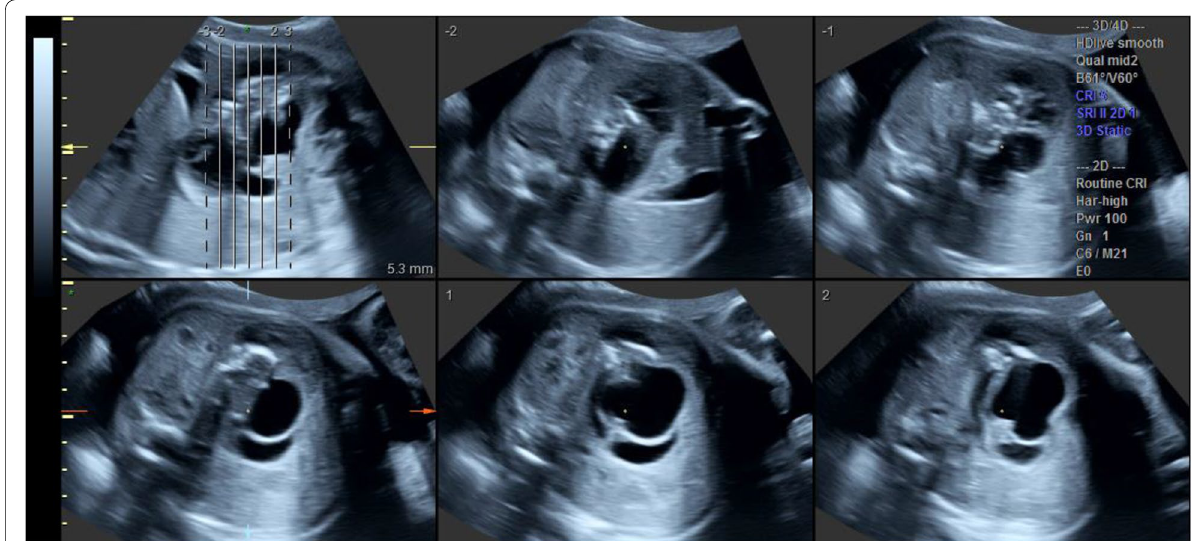
Fig. 1 Prenatal ultrasound showing a polycystic abdominal swelling in the fetus